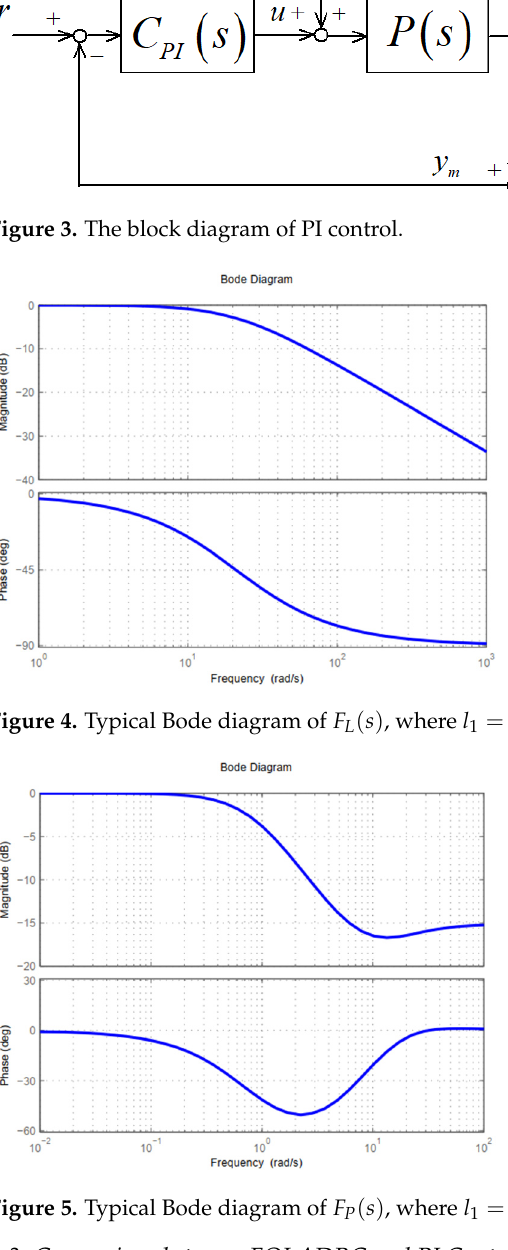
Figure 5. Typical Bode diagram of F P ( s ) , where l 1 = 1, β 1 = 20, β 2 =